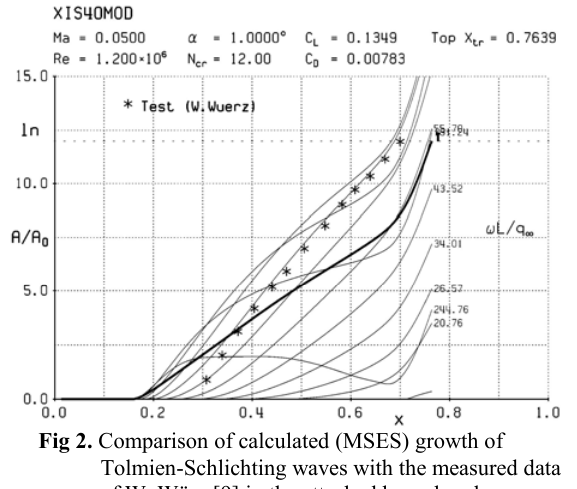
Fig 2. Comparison of calculated (MSES) growth of Tolmien-Schlichting waves with the measured data of W. Würz [9] in the attached boundary layer